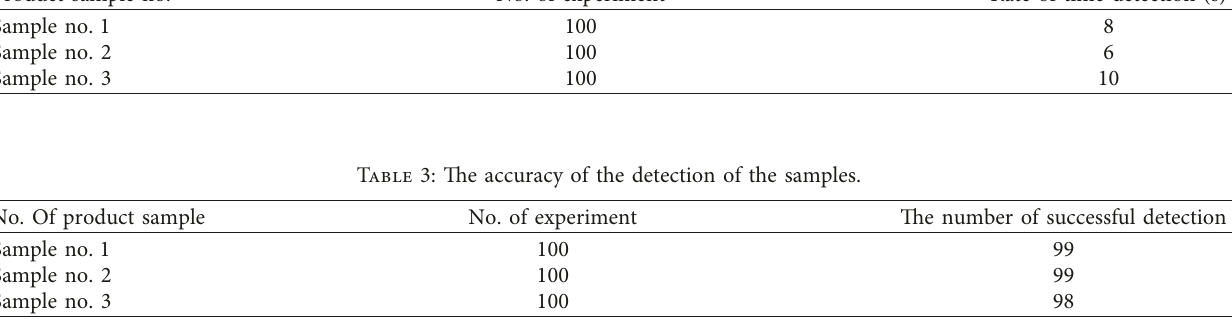
Figure 9: The matching of sample 3: (a) product image captured; (b) template image. Table 2: The average time needed for the detection of the samples. Product sample no.